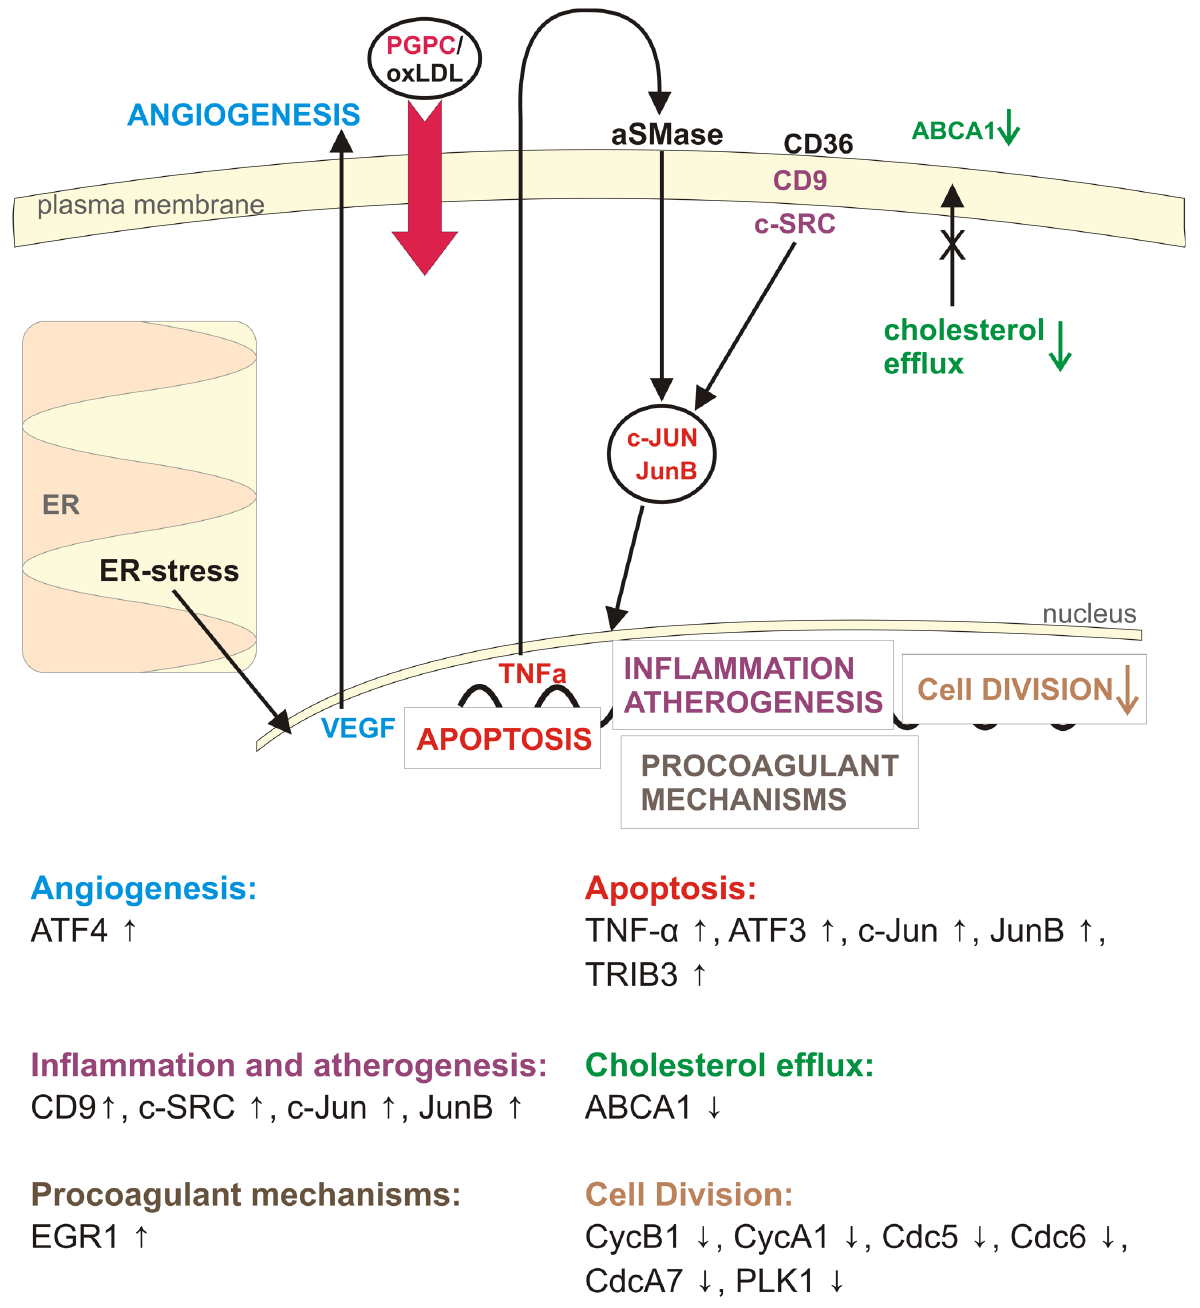
Figure 4. Biological processes and corresponding genes regulated by PGPC in RAW 264.7 macrophages.